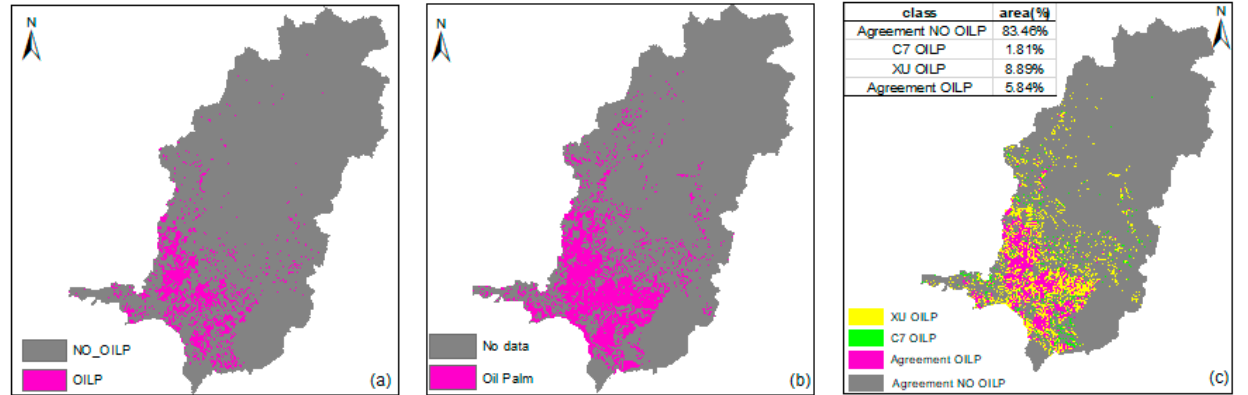
Figure 9. Classification map after binarization by ( a ) the combination 7, ( b ) XU2020, and ( c ) difference maps of combination 7 and XU2020 classification maps.